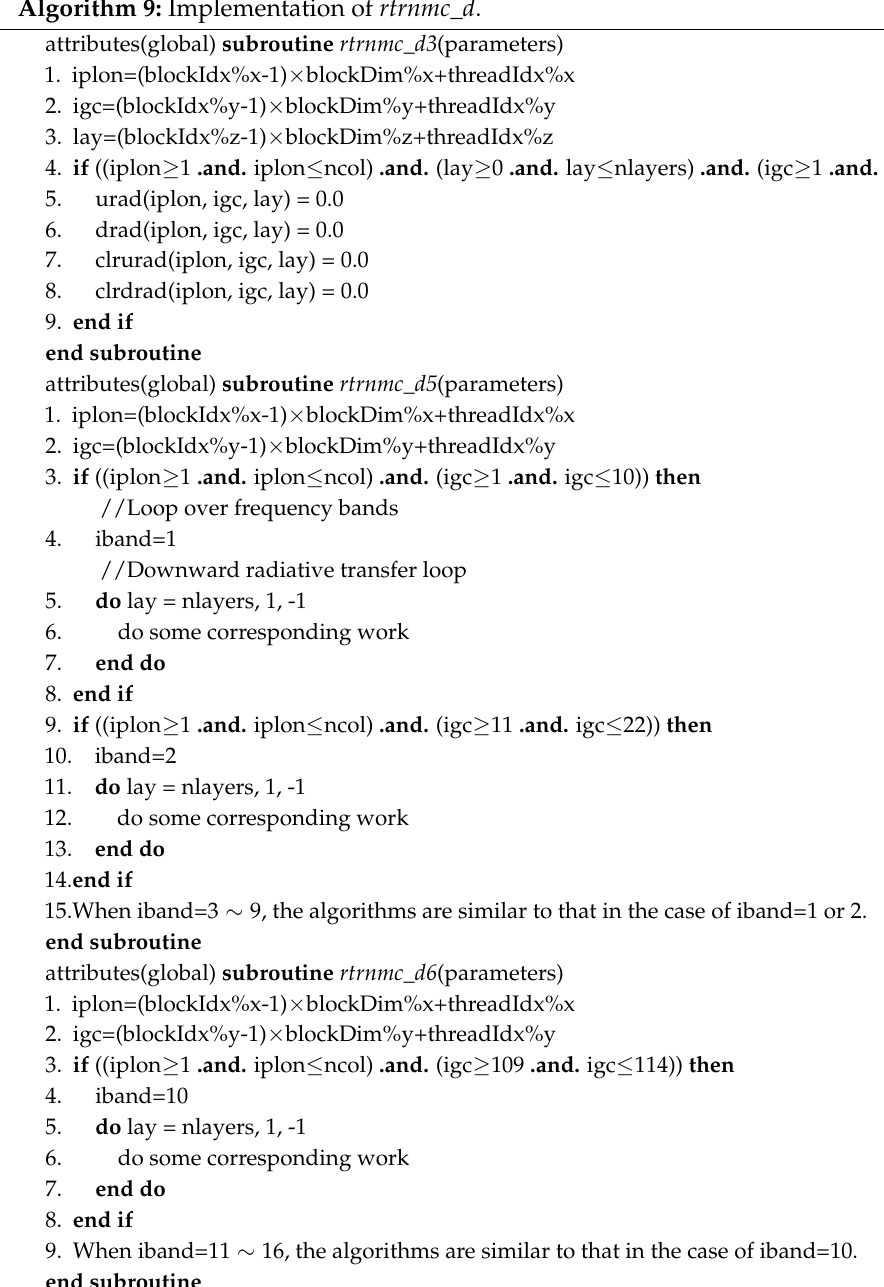
Algorithm 9: Implementation of rtrnmc_d